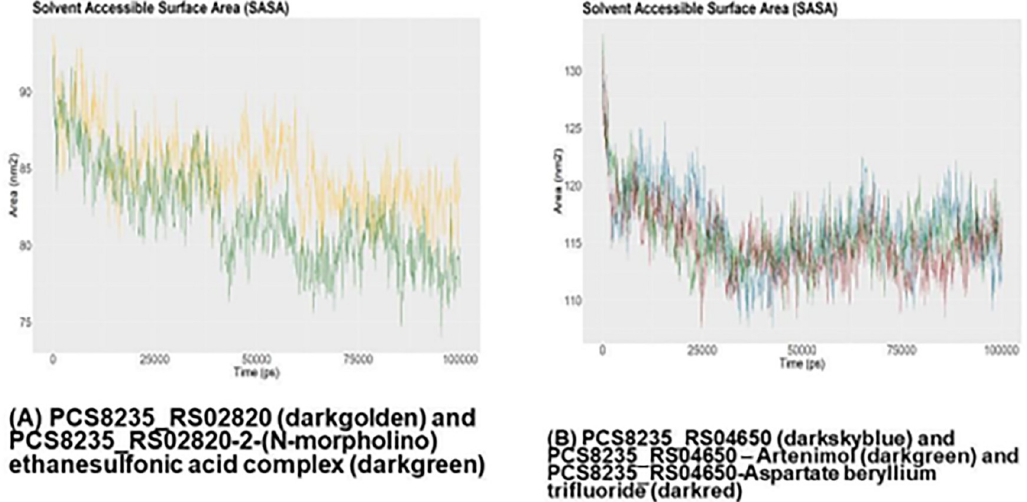
Fig 9. SASA calculation of (A) PCS8235_RS02820 (golden) and PCS8235_RS02820-2-(N-morpholino) ethanesulfonic acid complex (green) (B) PCS8235_RS04650 (blue) and PCS8235_RS04650 –Artenimol (green) and PCS8235_RS04650-Aspartate beryllium trifluoride (red) at